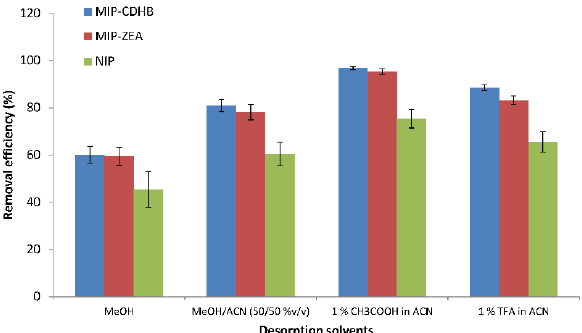
Figure 9. Effect of pH on the adsorption of ZEA onto MIP-CDHB, MIP-ZEA and NIP for the following adsorption conditions: adsorbent weight = 50 mg; initial concentration = 1 mg · L − 1 ; solution volume = 25 mL; T = 298 K, time = 60 min.